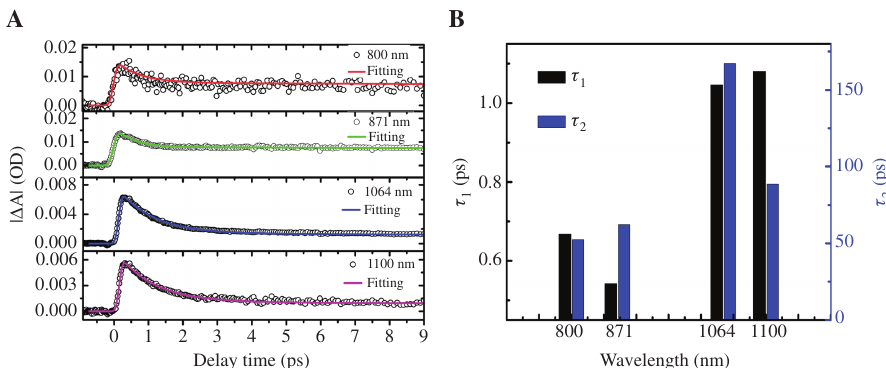
Figure 4: Transient absorption properties of GeSe NPs at different wavelength. (A) Transient absorption spectra as functions of pump-probe delay time at wavelengths of 800, 871, 1064, and 1100 nm, respectively. (B) Wavelength dependence of the fast and slow relaxation time constants τ